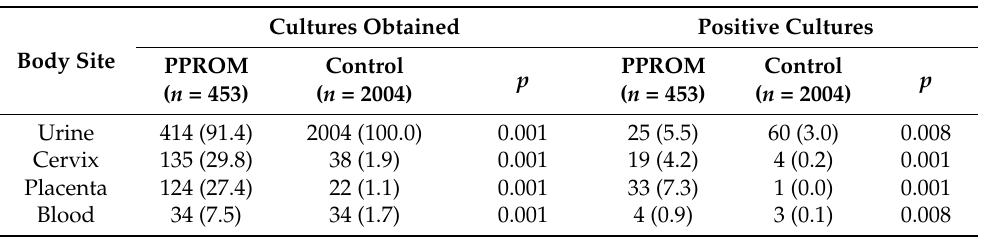
Table 3. Microbiological cultures—study group versus control group. PPROM: preterm premature rupture of